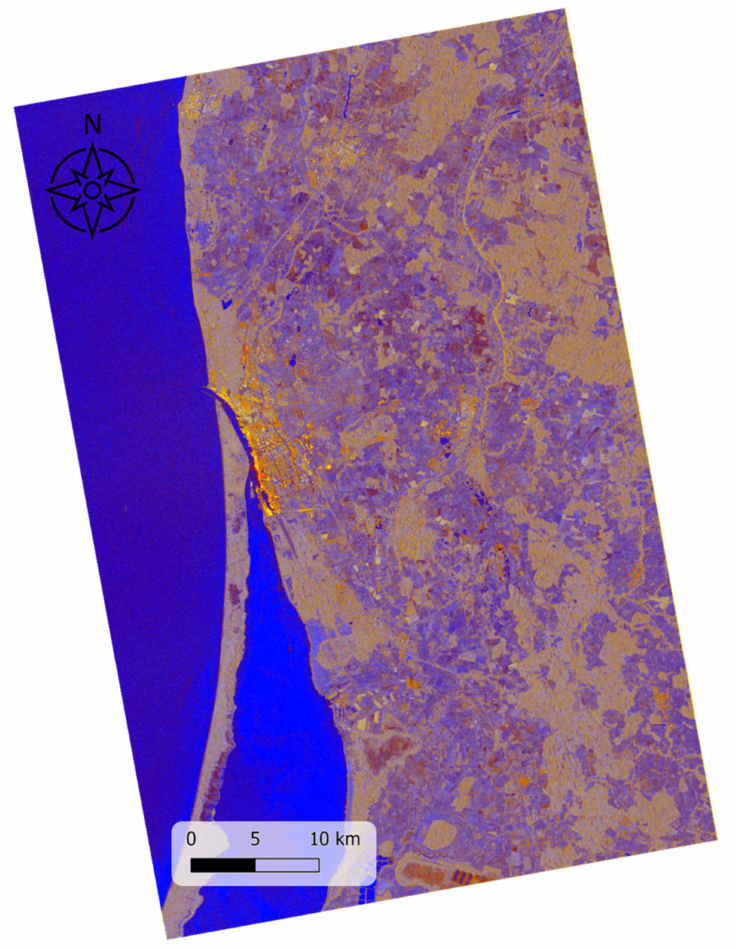
Figure 3. SAR image processed and prepared for analysis—VV, VH, VV/VH